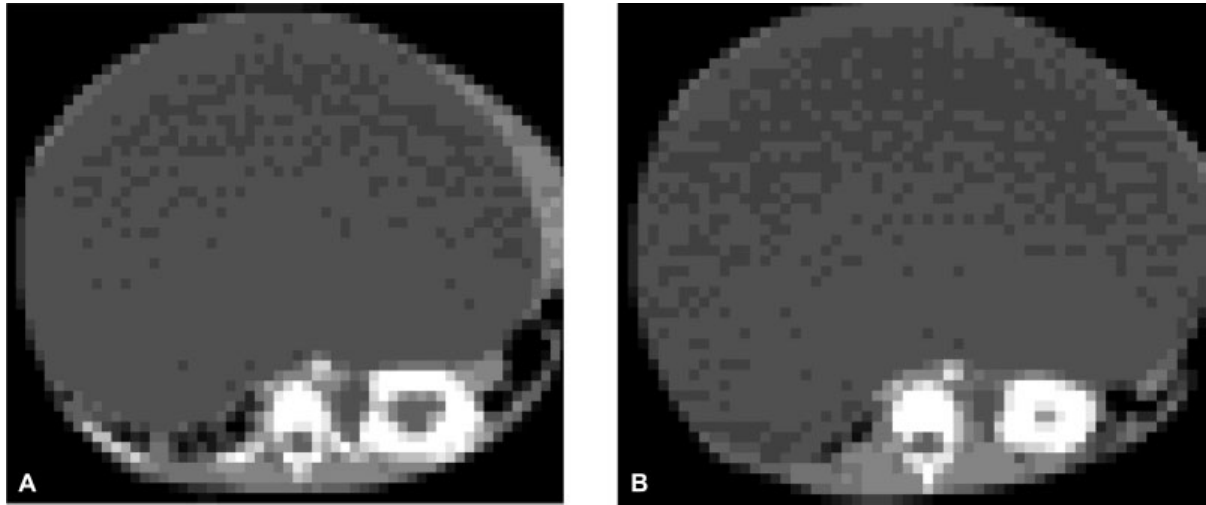
Fig. 2 ( A and B ) Axial post contrast CT scan of the abdomen, 20 (cid:1) 32 cm huge cystic mass displacing the entire visceral organt to the back, absent right kidney and dilatation of renal pelvis and calyces of left kidney due to mass effect. CT, computed